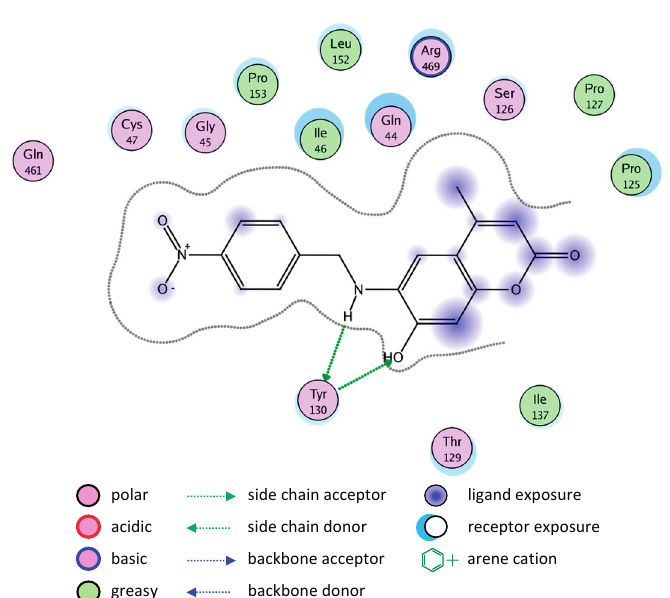
Figure 8. 2D representation of docking of compound 2 into the COX-1 active site.